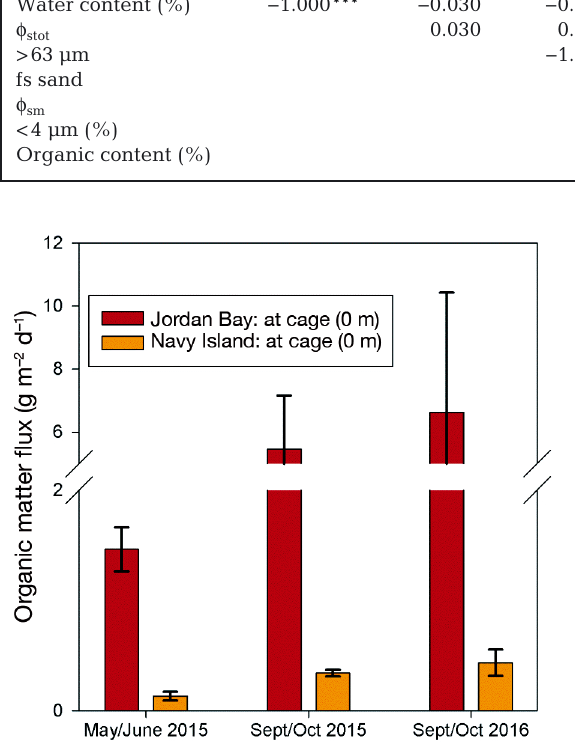
Fig. 7. Jordan Bay and Navy Island organic matter flux from all samplings. Error bars: 1